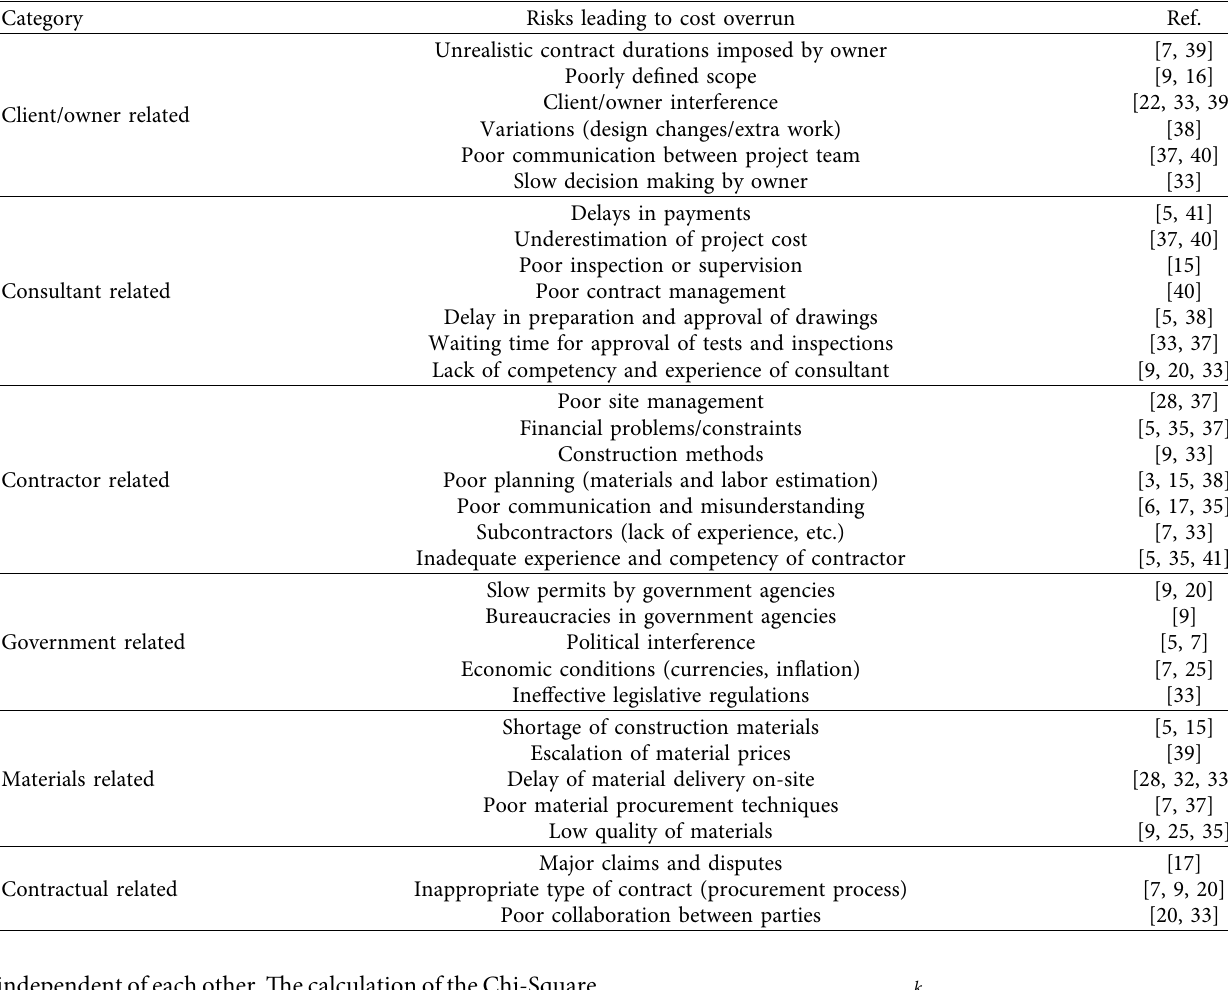
Table 2: Risk factors leading to schedule delays in infrastructure